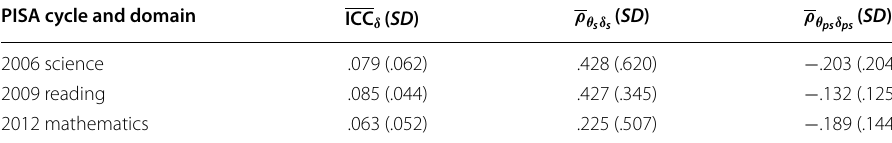
Table 4 Mean ICC for persistence, mean correlations of ability and persistence between schools and within schools, and standard deviations across countries in PISA assessments